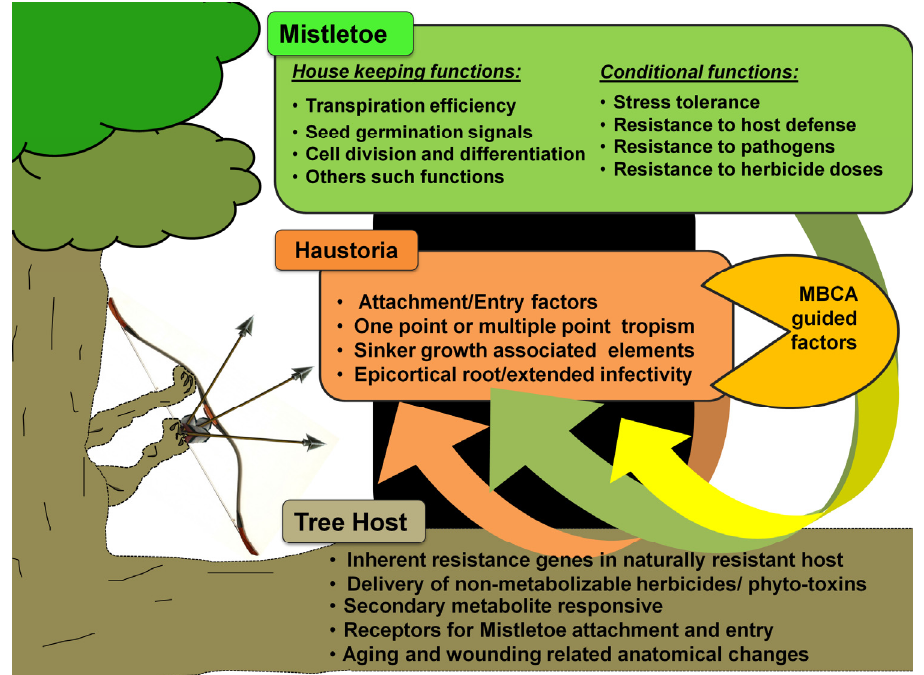
Figure 4. Resource-tapping possibilities from genetic pools to strategize transgenic host resistance to mistletoes. The gap in functional genomics studies on mistletoe parasitism has majorly limited the exogenous induction and/or introduction of mistletoe resistance in hosts. This would require, in principle, the characterization of genetic targets in mistletoe and tree hosts that signal and favor easy entry to mistletoes (shown here) and then testing of the conventional gene manipulation and transgenics’ frameworks (see Figure 5). Even putative MBCAs can be screened for genetic elements encoding factors detrimental to mistletoe parasitism and/or its life cycle.